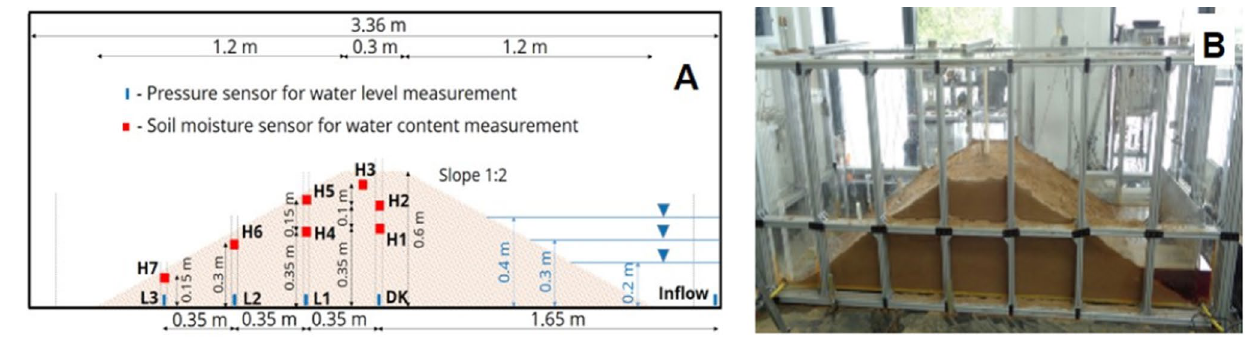
Fig. 1 Sketch of the experimental setup including the positions of soil moisture sensors and pressure head sensors ( A ) and picture of the dike experiment exemplary with 20 cm flooding ( B